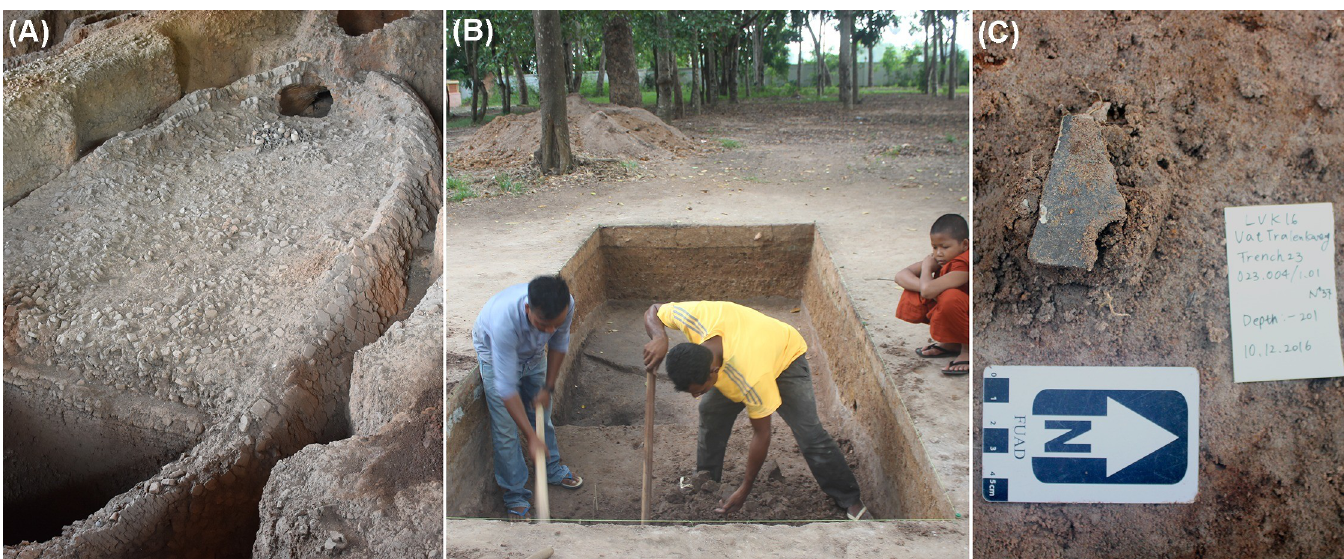
Fig 2. Production and consumption sites of brown-glaze stoneware storage jars. (A) Bang Rachan (Maenam Noi) Kilns no. 1 & 5. Image credit: Martin Polkinghorne. (B) Wat Tralaeng Kaeng—Trench 23. Image credit: Sok Keo Sovannara. (C) Brown-glaze sherd in-situ at Longvek—BCG100, South China. Image credit: Sok Keo